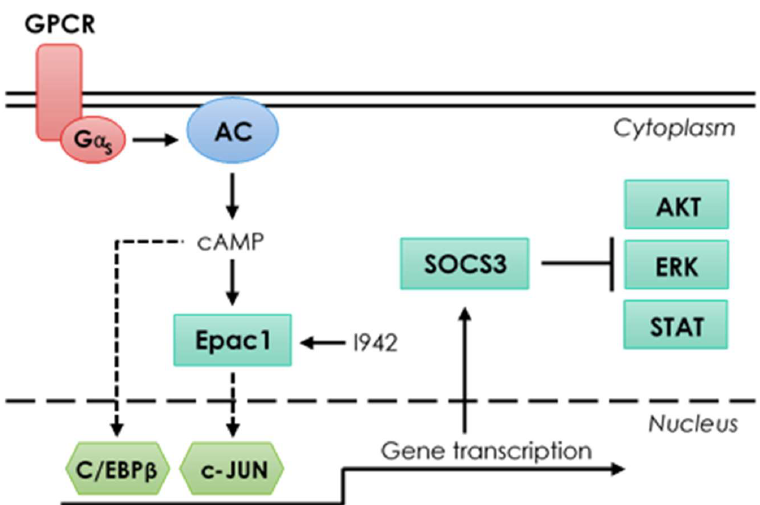
Figure 11. Summary of signalling mechanisms in the present study.